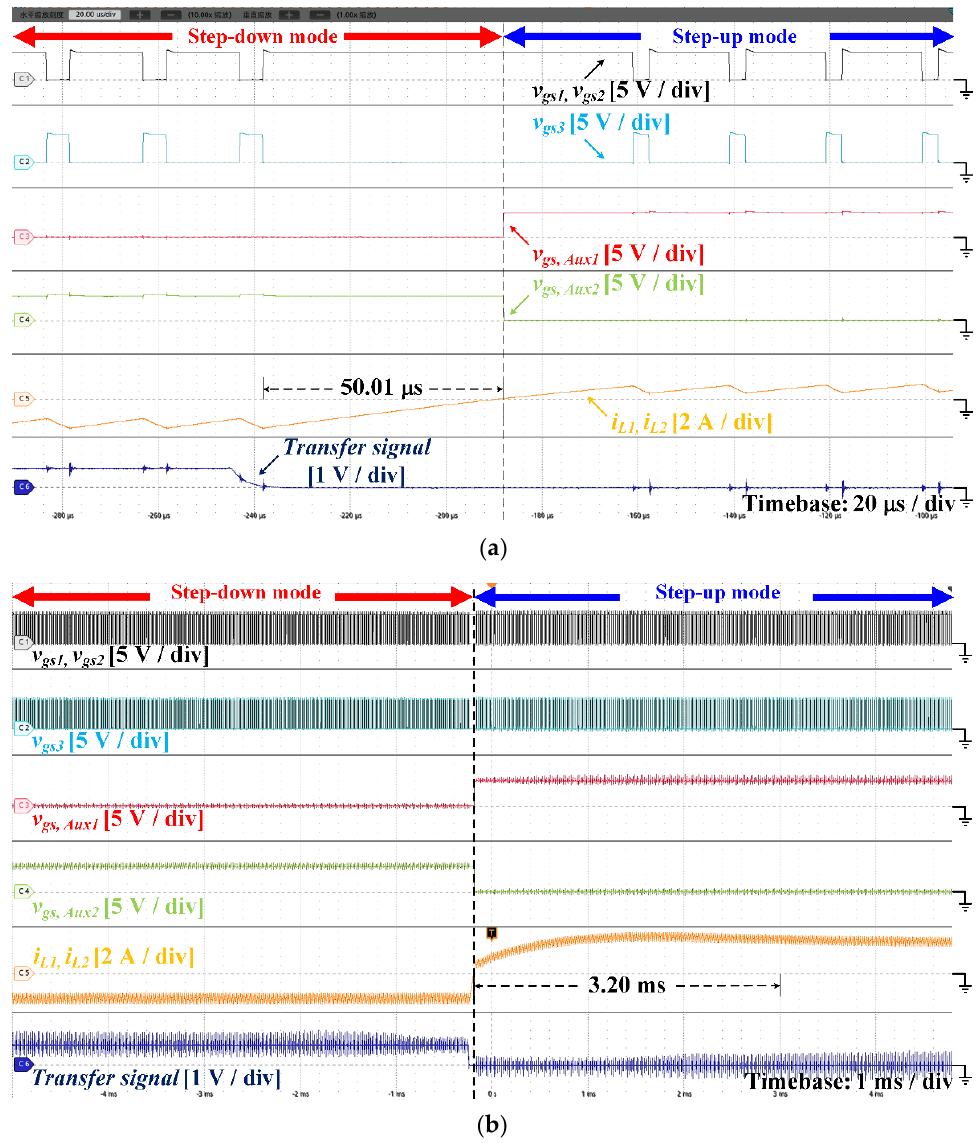
Figure 17. Waveforms of dynamic performances with 50% load condition. ( a ) v gs1 , v gs2 , v gs3 , v gs,Aux1 , v gs , Aux2 , i L1 , i L2 , transfer signal. ( b ) Change from the step-down mode to the step-up mode.